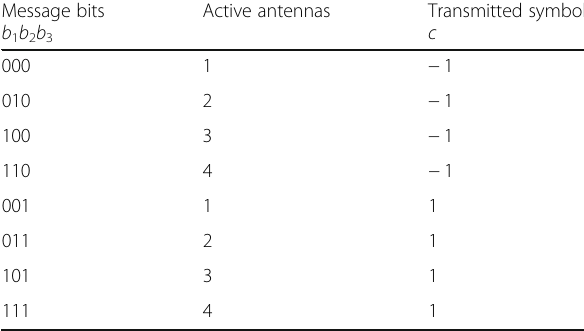
Table 1 The transmission and encoding of SM scheme with 3 bits/channel use, four transmit antennas, and BPSK modulation Message bits b 1 b 2 b